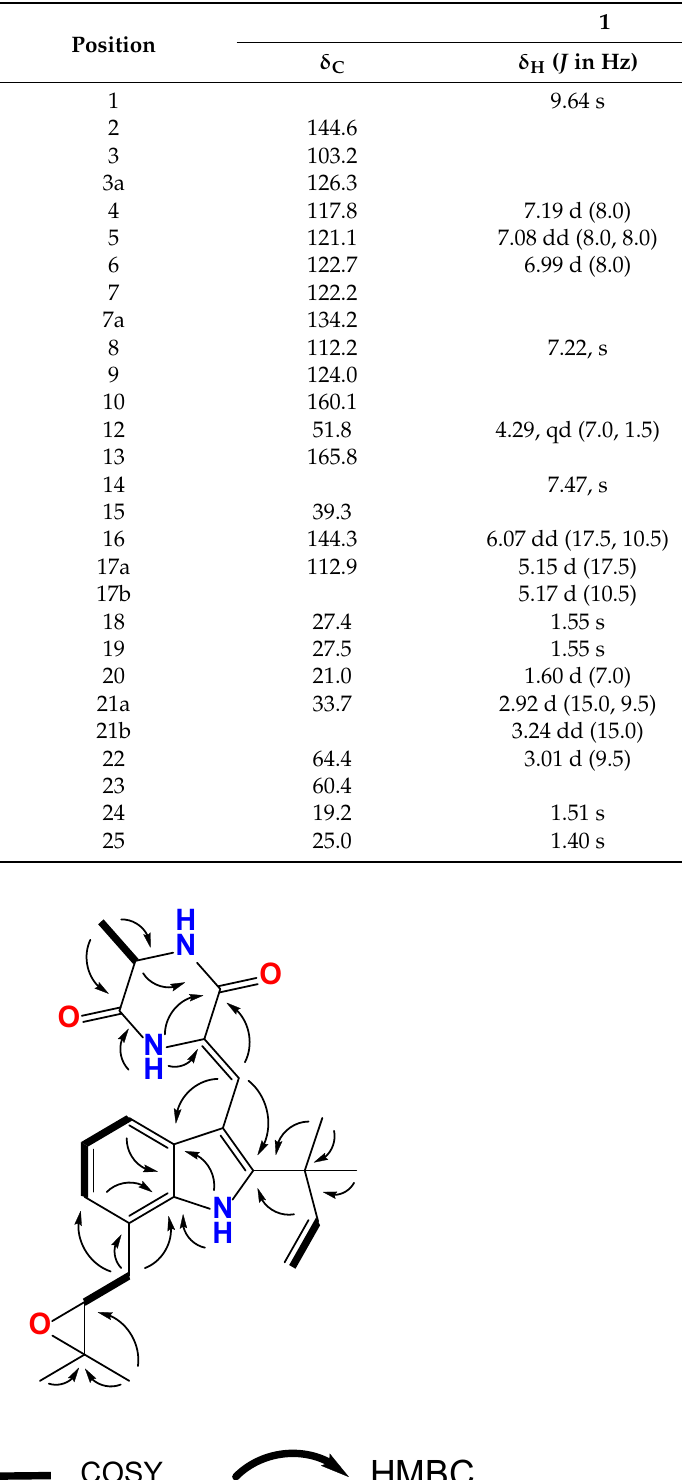
Table 1. 1 H (500 MHz) and 13 C NMR (125 MHz) data of Compound 1 (in CDCl 3 ).